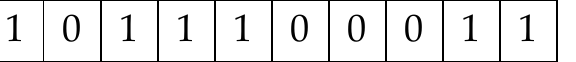
Table A1 details the worst-case time complexity of the main loop of I-NOSGA. The